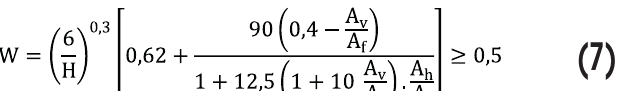
Values of “M” in function of the structural material